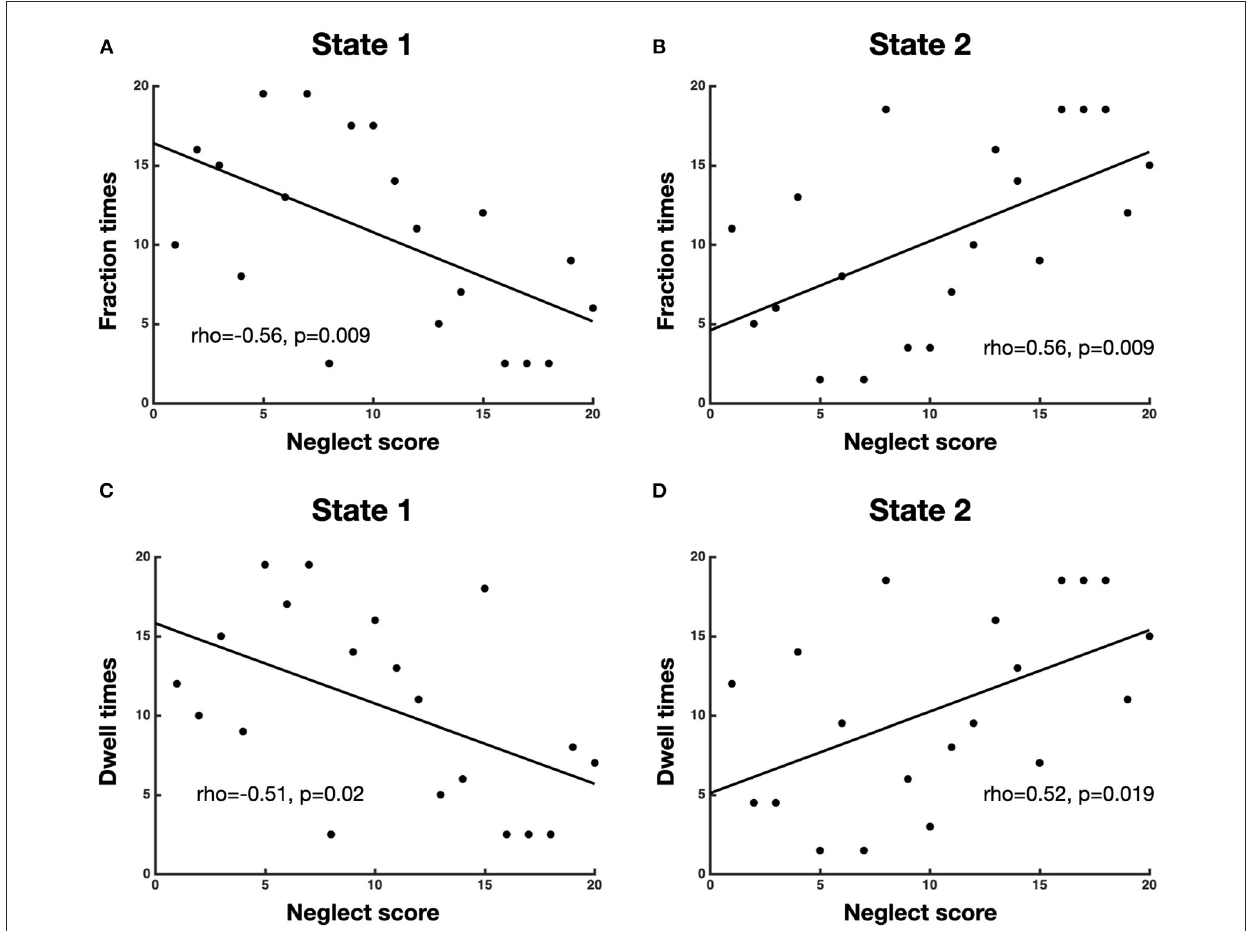
FIGURE3 Association between neglect severity and temporal dynamics of brain states. The scatterplots display the Spearman rank correlation between neglect score and fraction times of state 1 (A) and state 2 (B) as well as dwell times of state 1 (C) and state 2 (D) . Each dot represents a patient ( n = 20). To be noted, high value on x-axis (neglect score) means severe neglect and vice